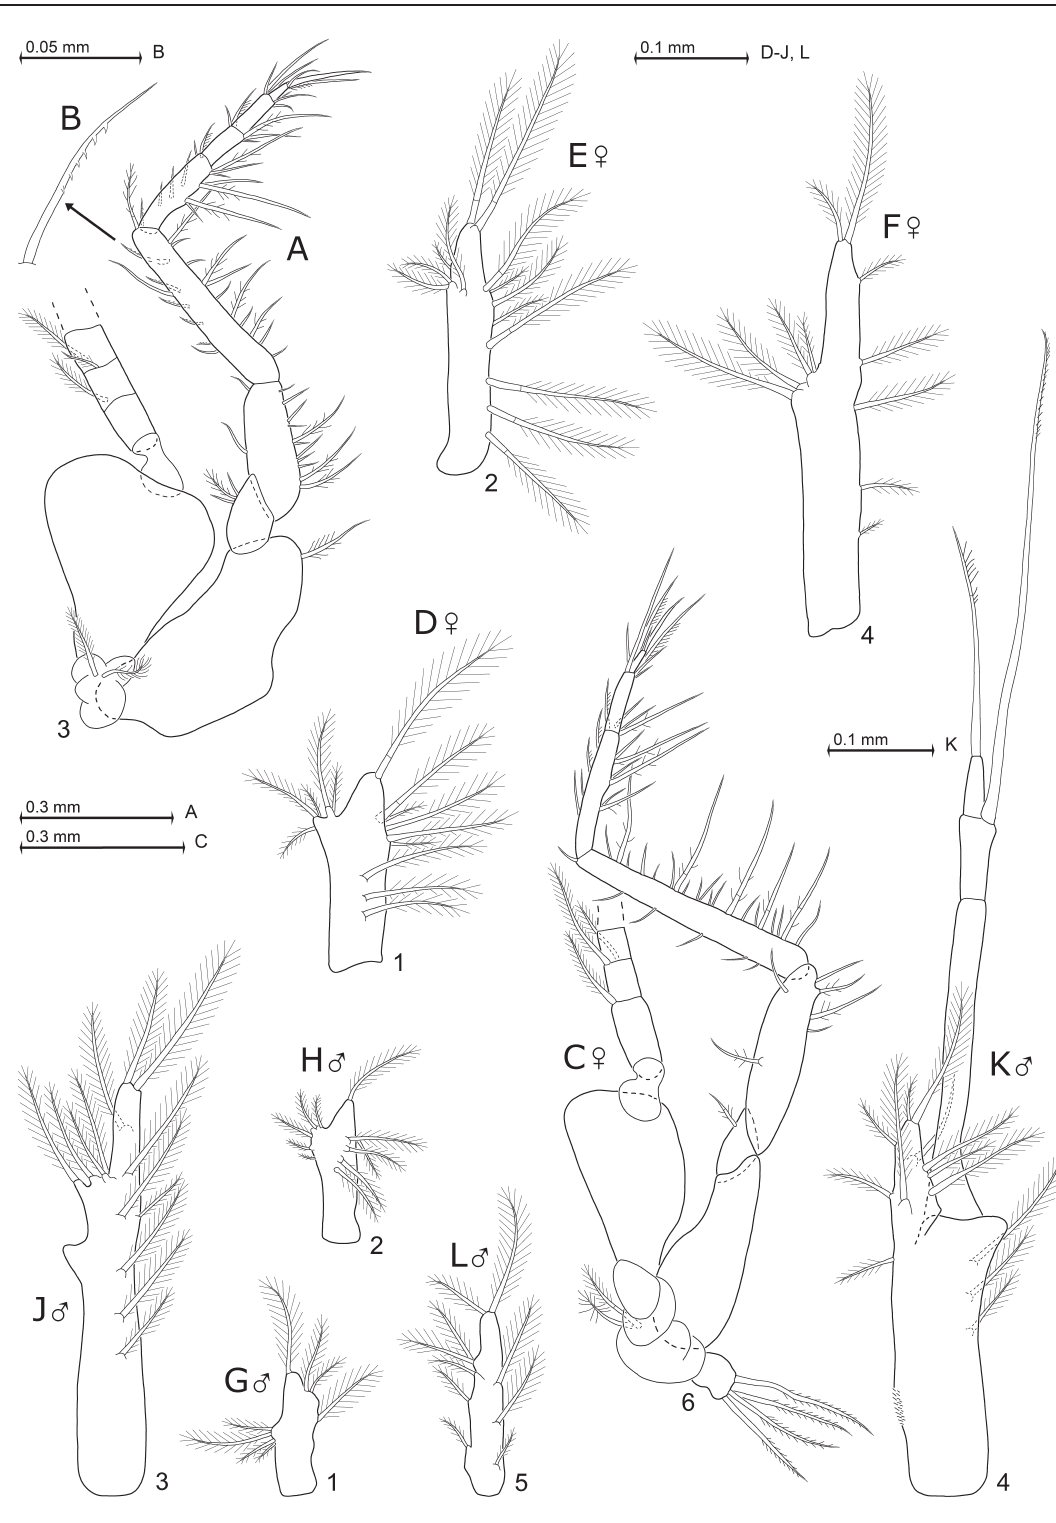
Fig. 12. Mysidium antillarum Wittmann sp. nov., from Curaçao, paratypes. A–B . ♂, 7.5 mm body length. C . ♀, 7.9 mm. D–F . ♀, 7.5 mm. G, J–K . ♂, 5.5 mm. H, L . ♂, 5.0 mm. A . Third thoracopod, caudal. B . Detail of panel (A) showing modified seta from merus. C . Sixth thoracopod with rudimentary oostegite, rostral view. D–F . Series of female pleopods 1, 2, 4, rostral view. G–J , L . Series of male pleopods 1–3, 5, rostral view. K . Male pleopod 4,